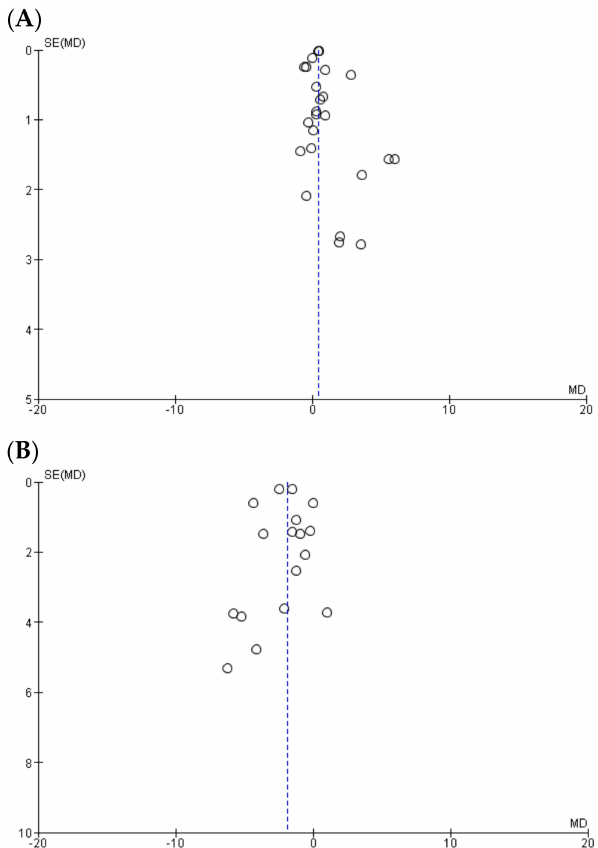
Figure 3. Funnel plot showing study precision against the mean difference effect estimate with 95% confidence interval for ( A ) adiponectin and ( B ) leptin. SE—standard error, MD—mean